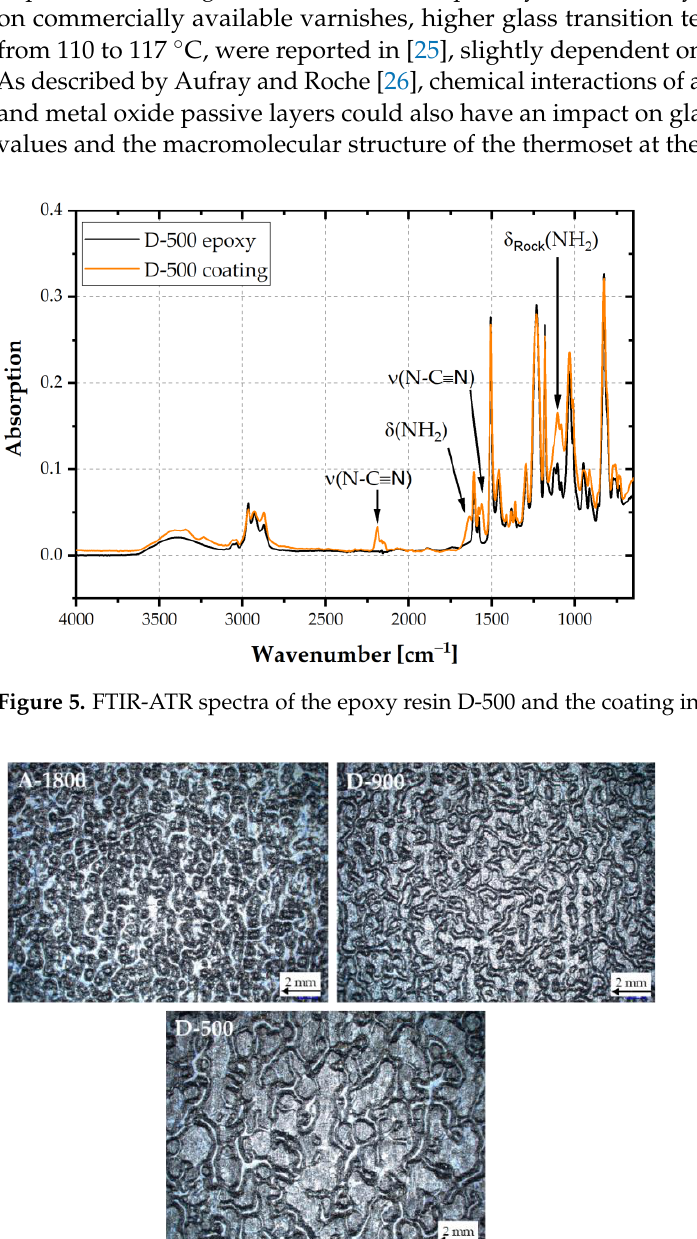
Figure 4. FTIR-ATR spectra in the range from 3700 to 2700 cm − 1 ( left ) and 1100 to 850 cm −1 ( right ) of epoxies with average EEW values of 500, 900, and 1800 g/mol.